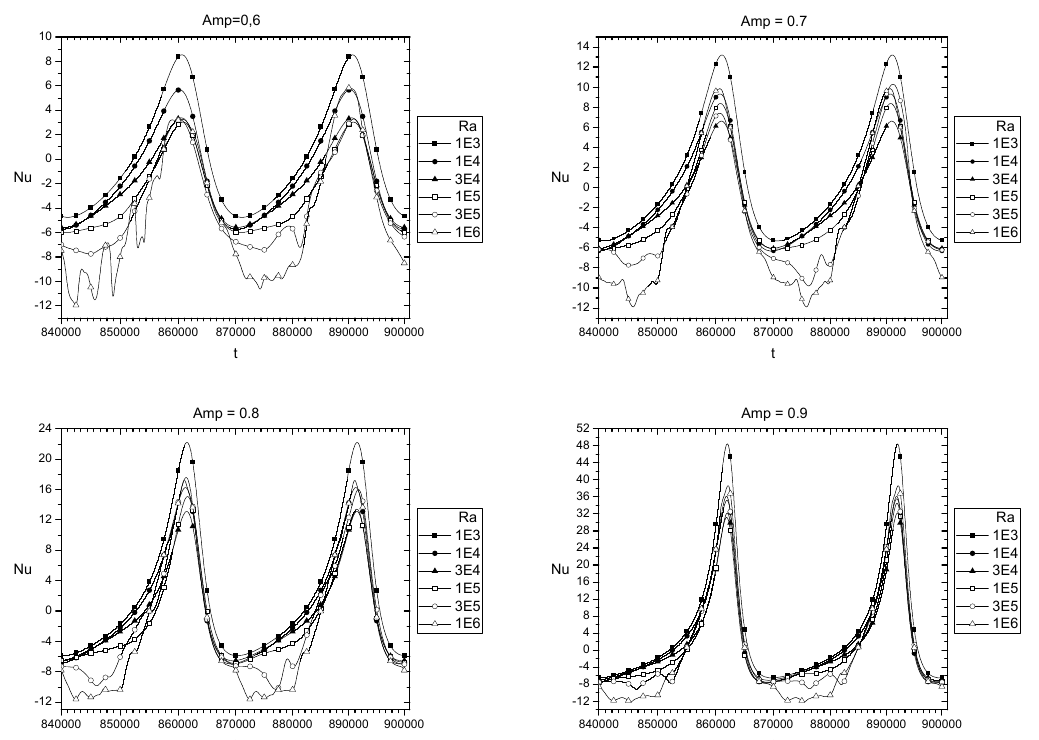
Figure 8. Evolution of the Nusselt number “Nu c ” (at the top wall) as a function of time for different Ra over the last two periods.